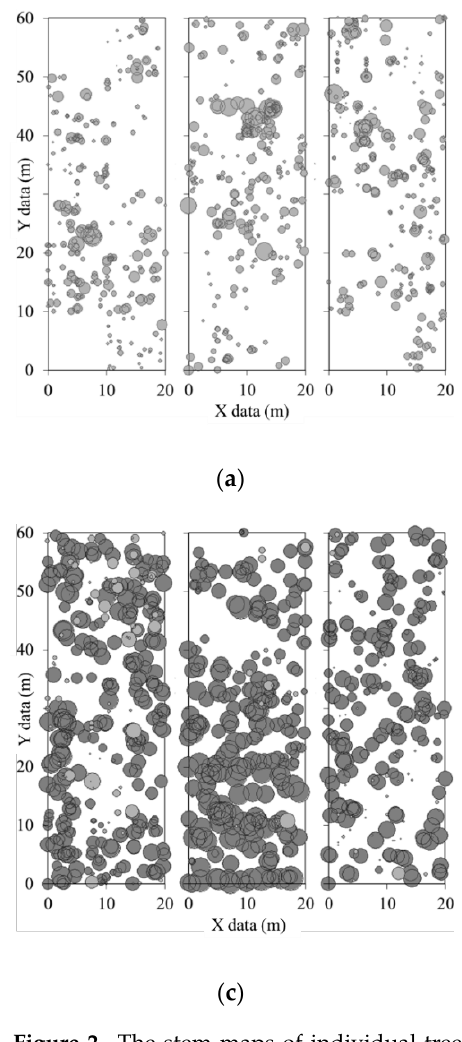
Figure 2. The stem maps of individual tree species in nine plots in bamboo expandatory phases: ( a ) early, ( b ) middle, and ( c ) later. Circles represent the locations of individual plants. Sizes are proportional to tree height; dark grey circles represent moso bamboo, light grey circles represent native forest